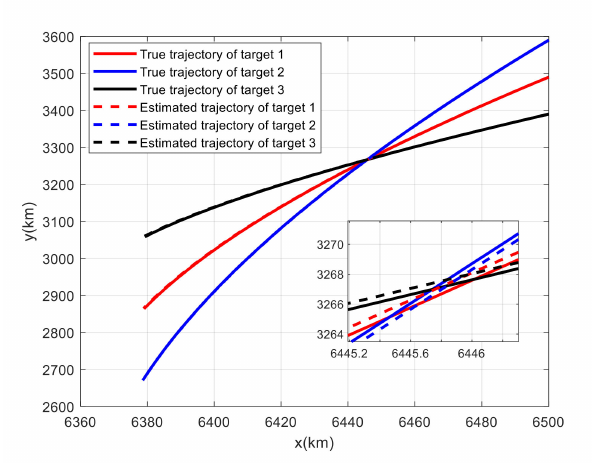
Figure 20. True and estimated tracks using the RL-JPDA in Case 1.